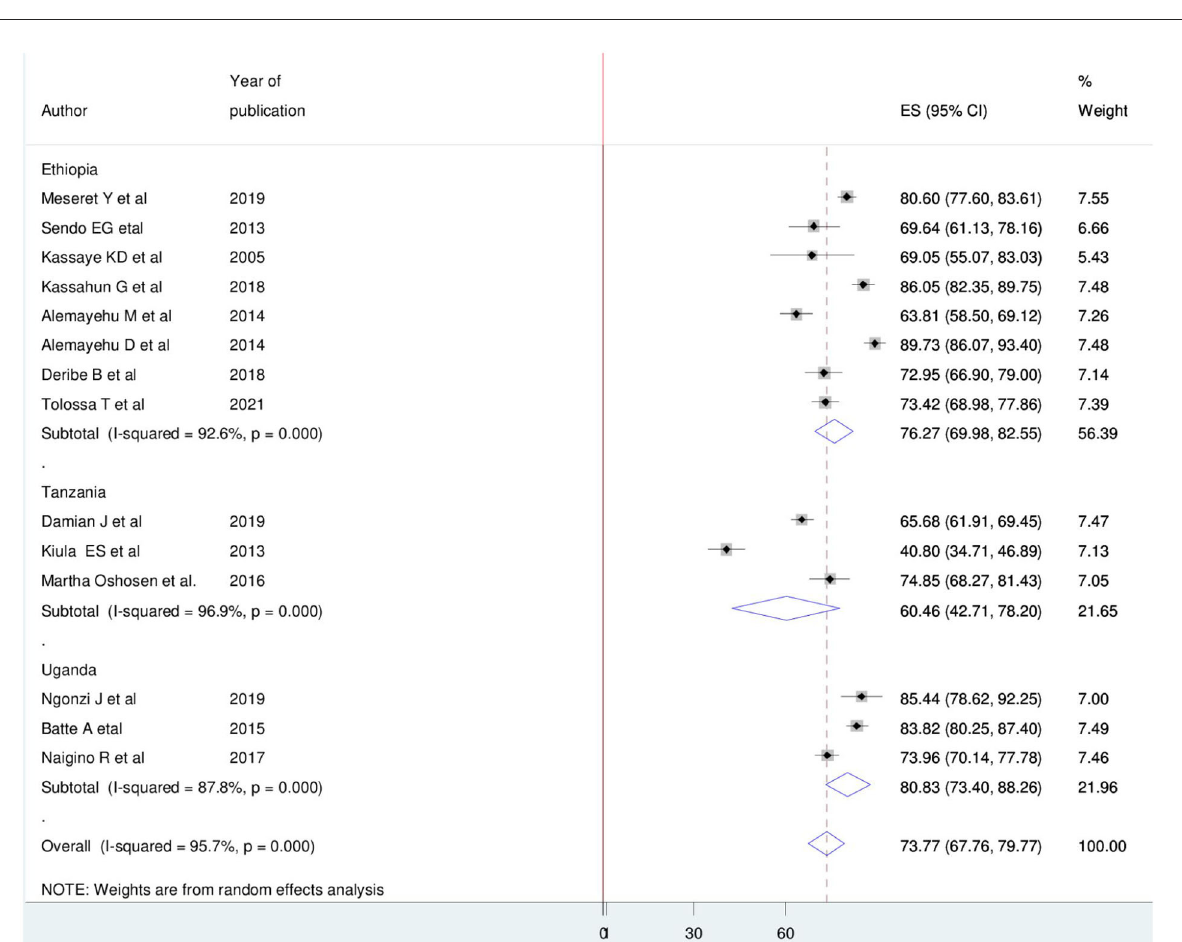
FIGURE3 Subgroup analysis on pooled magnitude of HIV positive sero-status disclosure among women in East Africa,